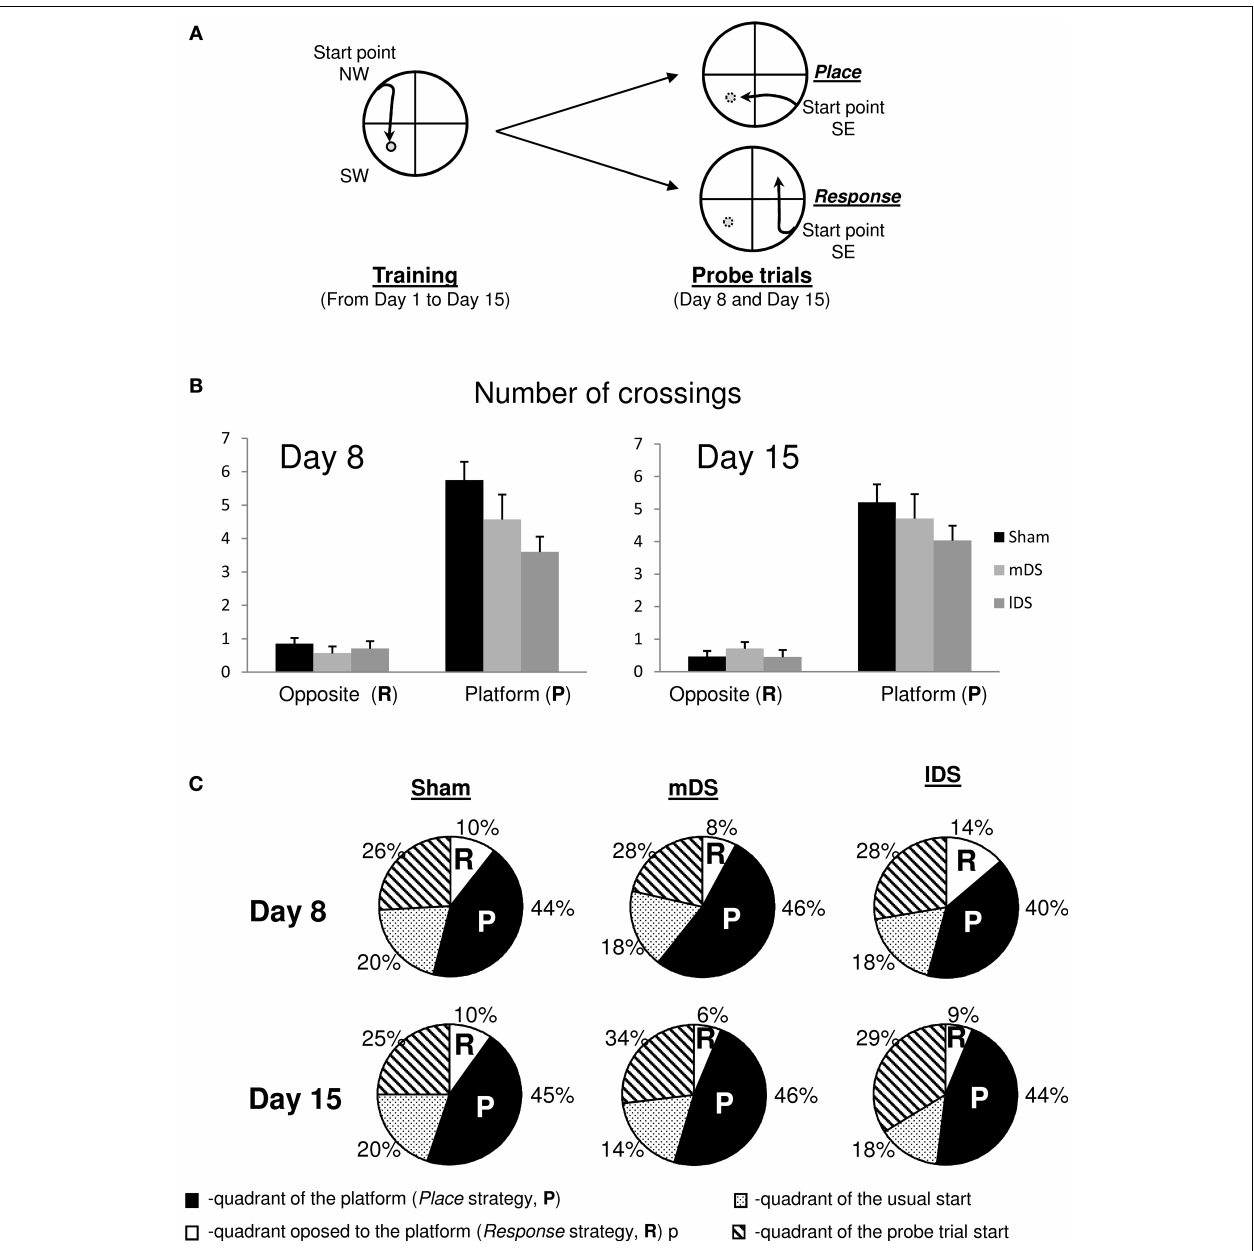
water maze. (C) Proportion of time spent in each quadrant of the water maze in sham and lesioned rats during the two probe trials. Four quadrants have been defi ned: the quadrant used for start during training, that used for start during the probe trial, that that had containing the platform (P) and the opposite quadrant (R). All rats spent signifi cantly more time in the Place quadrant than in the Response quadrant, irrespectively of the lesion type and the amount of